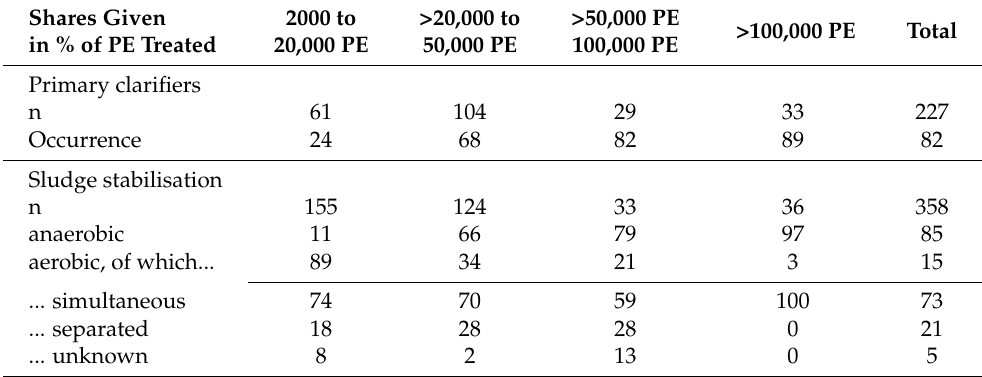
Table 3. Primary clarifier abundance and use of various sludge stabilization methods in different size groups of Austrian wastewater treatment